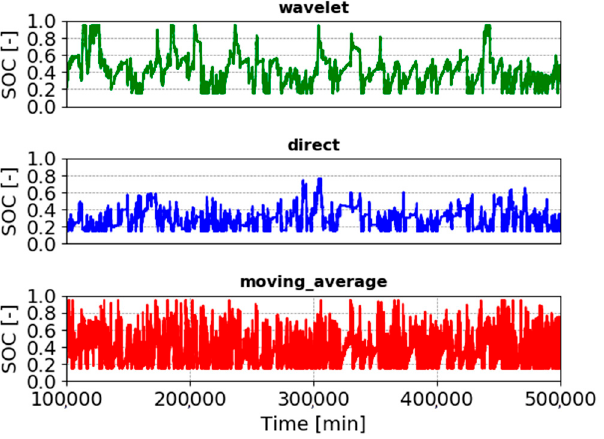
Figure 18. Comparative analysis of SOC profiles for the three methods (same battery capacity = 330